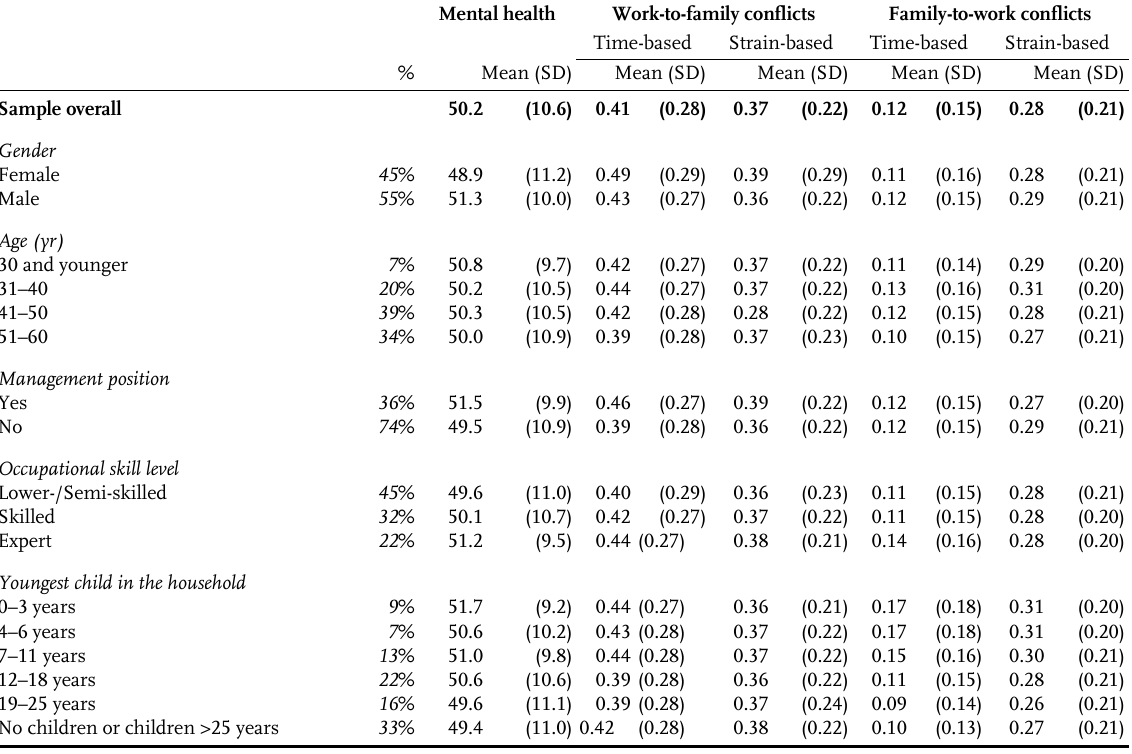
Table 1 : Means and standard deviations of mental health , work-to-family conflicts , and family-to-work conflicts Mental health Work-to-family conflicts Family-to-work conflicts